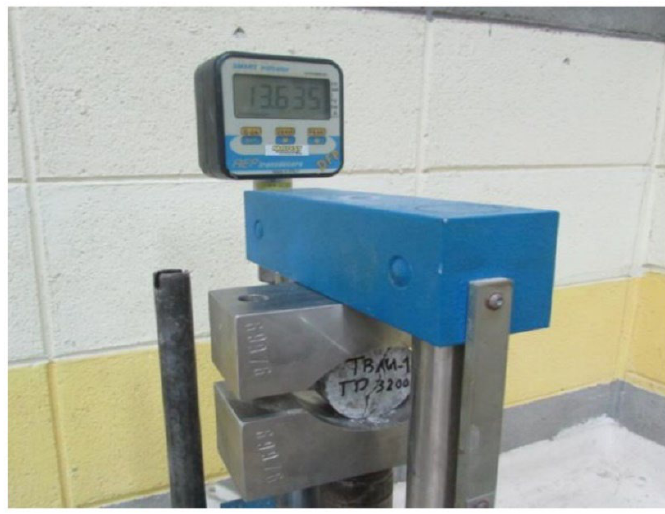
Figure 1. Failure of a sample under a BTS test [3].